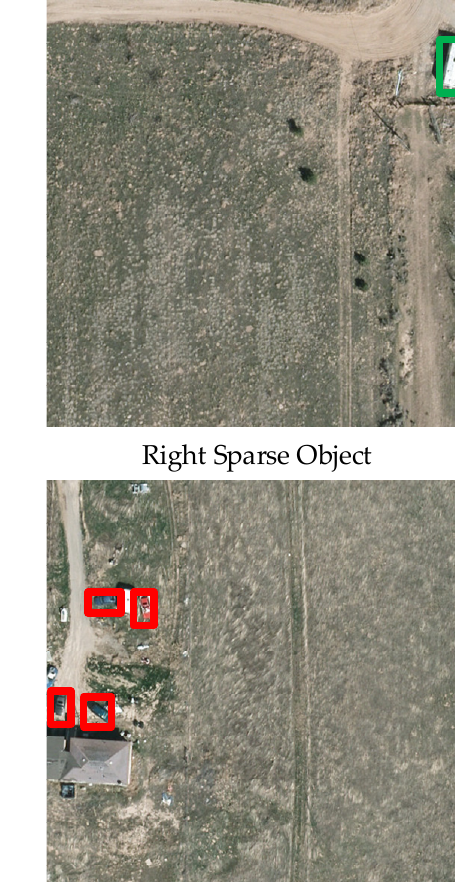
Figure 4. Sparse object distribution.